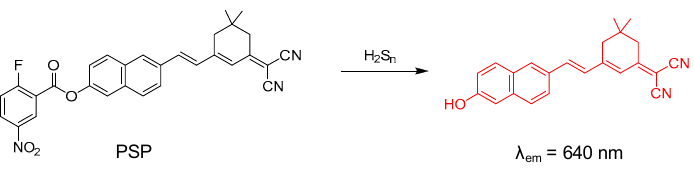
Figure 16. The two − photon NIR fluorescence response of PSP and H 2 S n [72].